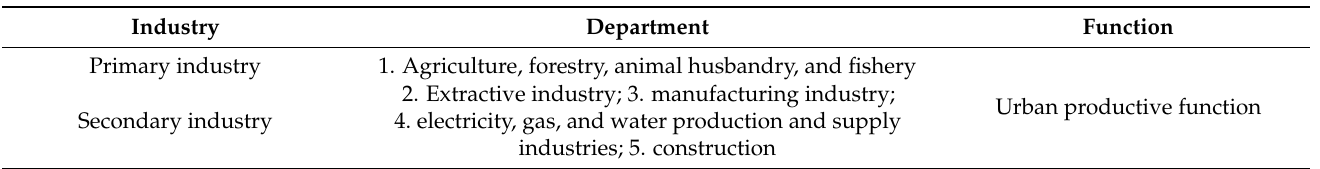
Table 1. Industrial sectors of the urban